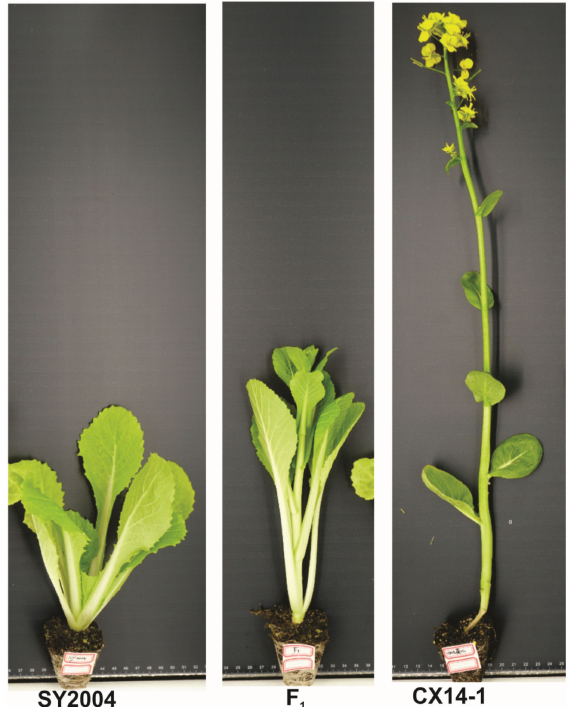
Figure 1. Phenotype of ‘CX14-1’ (P 1 , early-bolting), ‘SY2004’ (P 2 , late-bolting) and their F 1